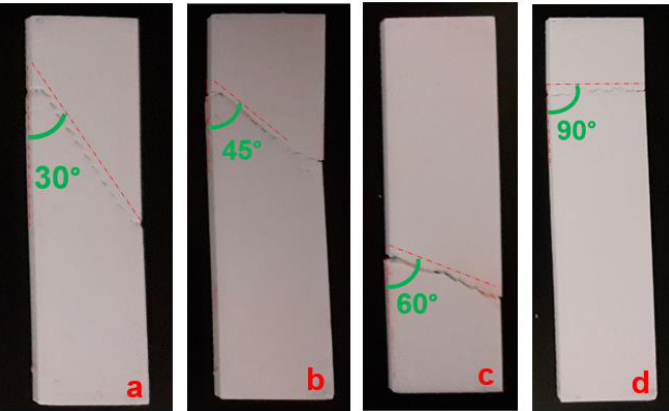
Figure 18. Macroscopic fracture view of the fabricated samples with reinforcement directions of ( a ) 30°, ( b ) 45°, ( c ) 60°, and ( d ) 90°.